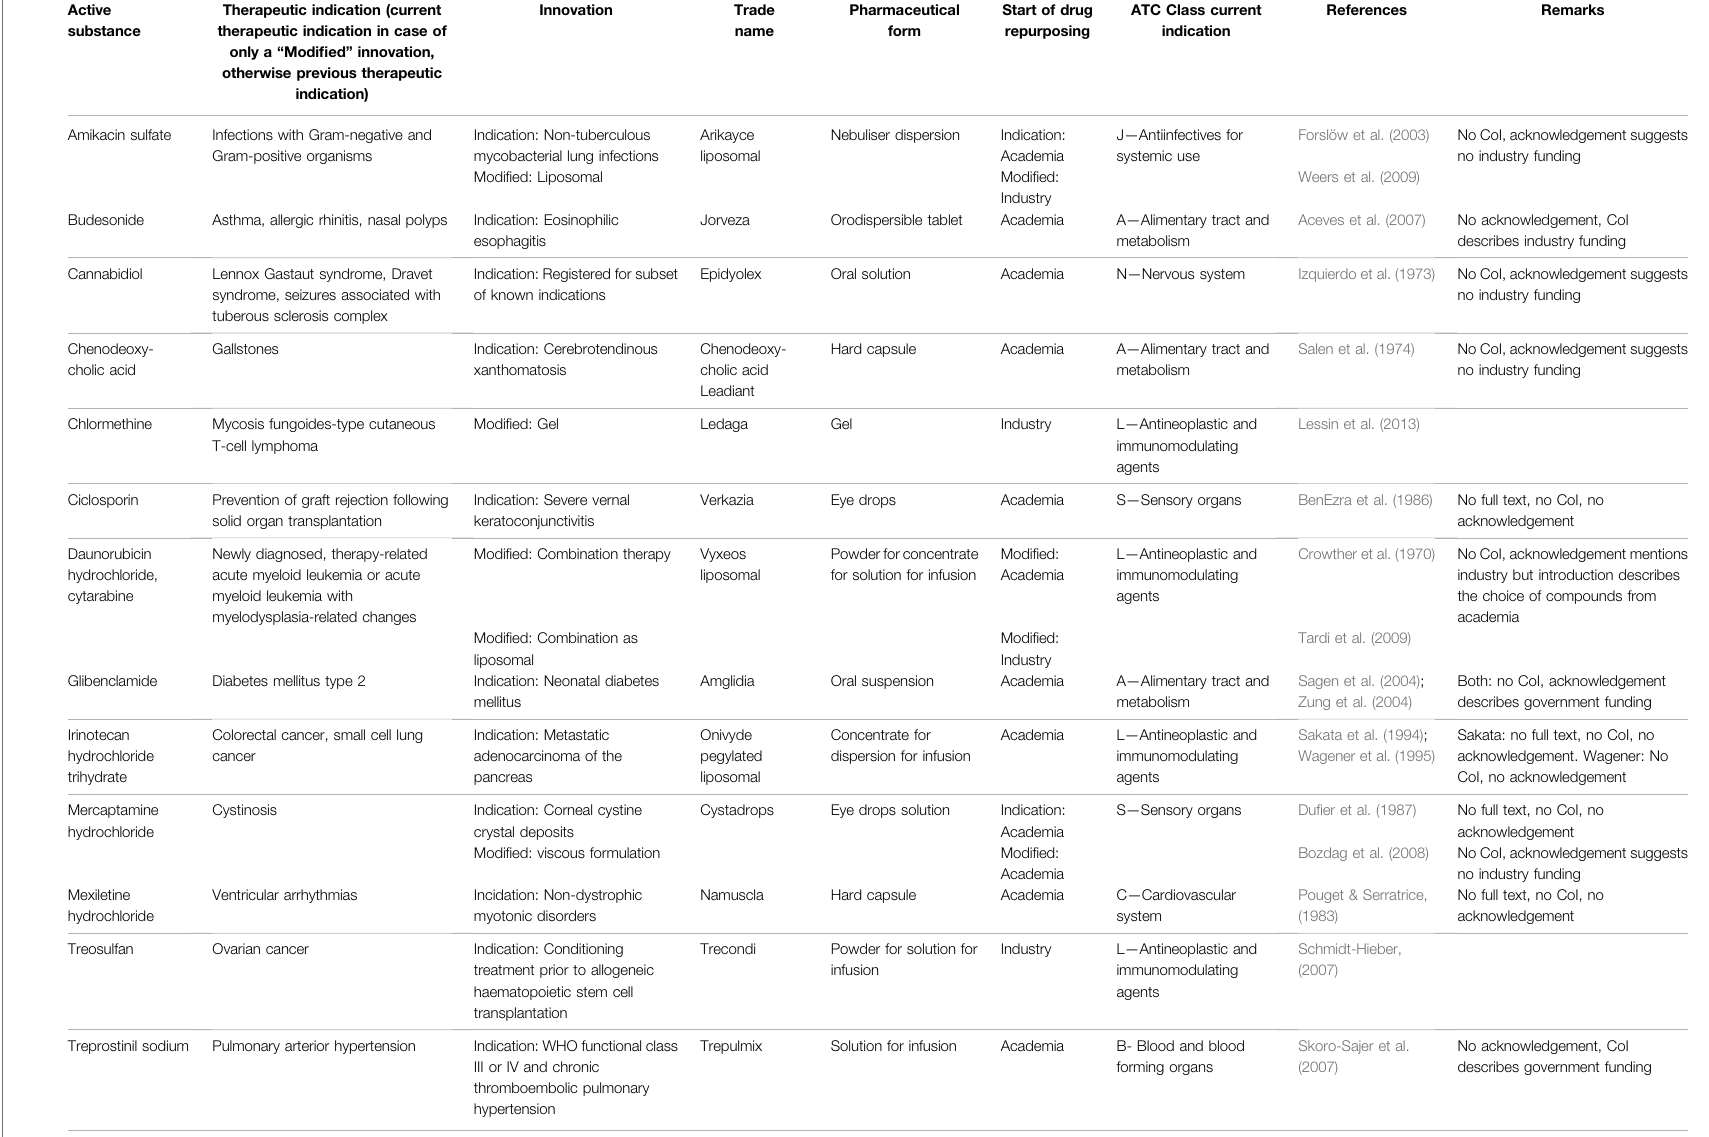
TABLE 1 | Repurposed orphan medicinal products approved between January 1st, 2016 and December 16th, 2020. CoI: con fl ict of